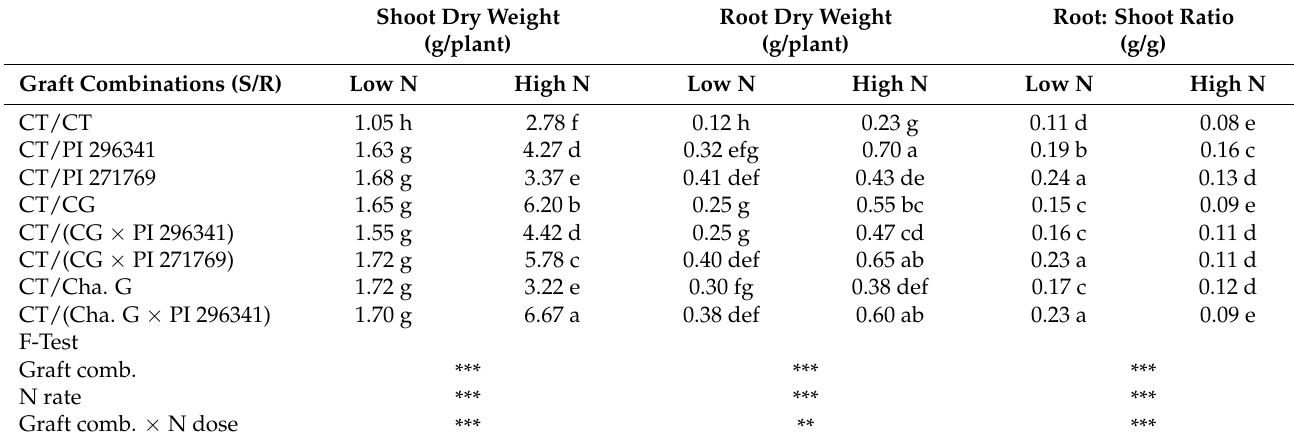
Table 2. Shoot dry weight and root dry weight and root: shoot ratio of self-grafted and